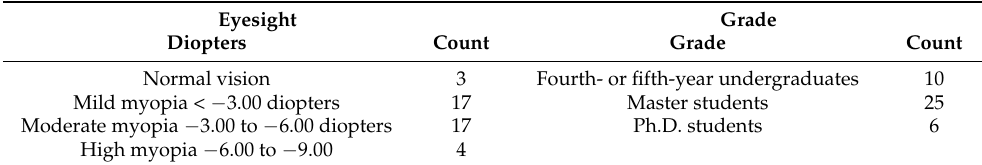
Table 2. Eyesight and grade information of 41 participants. Eyesight Grade Diopters Count Grade